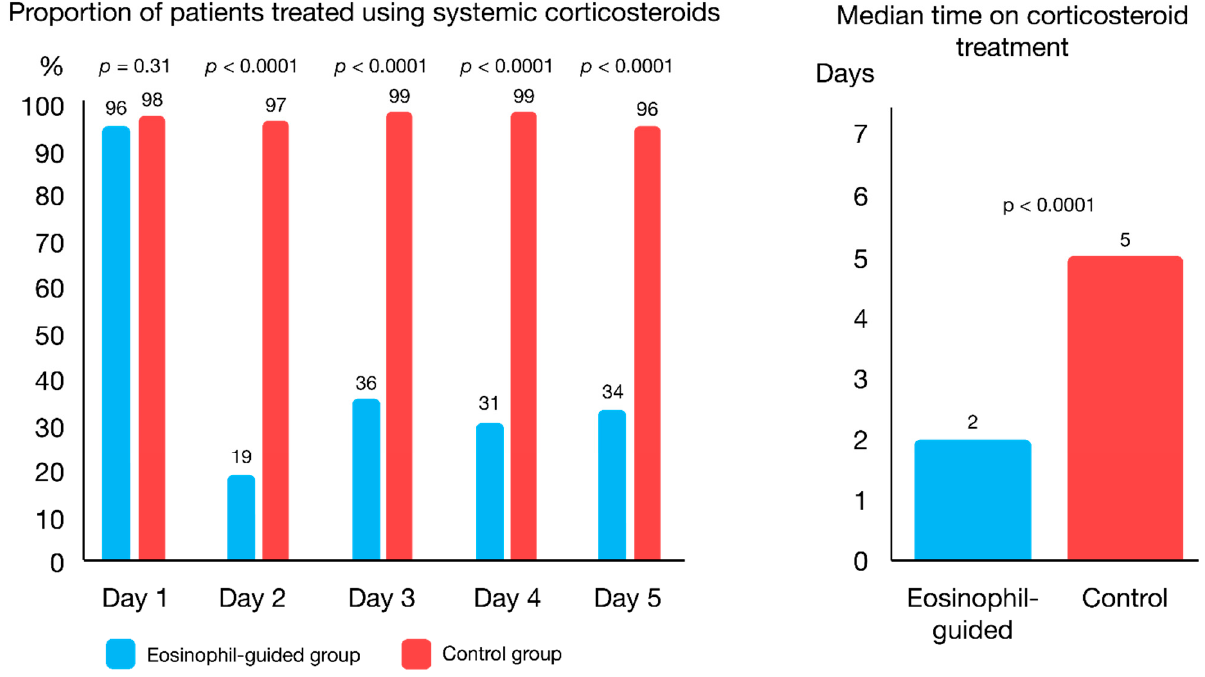
Figure 2. Fraction of patients on systemic corticosteroid treatment and the median treatment length in the CORTICO-COP trial—adapted from Sivapalan et al.